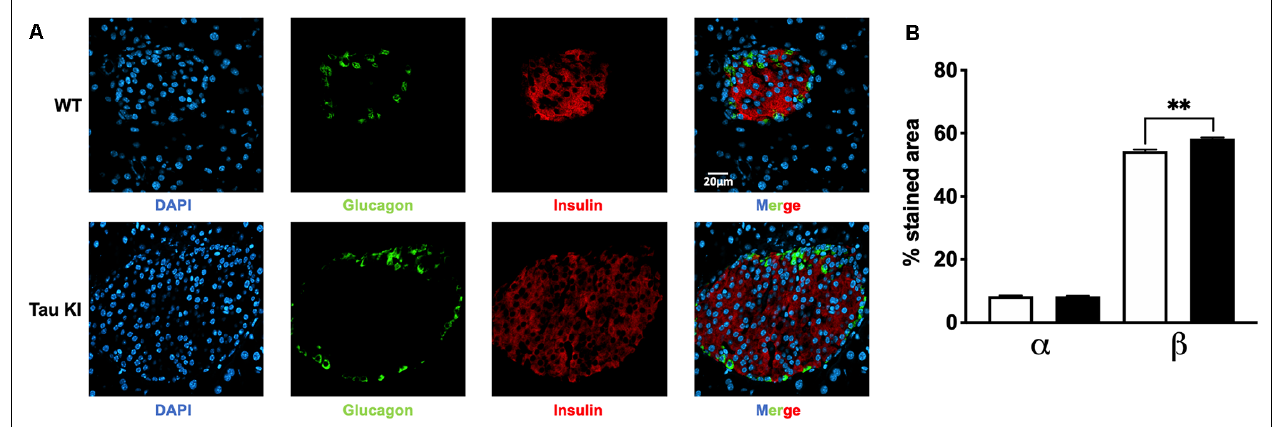
FIGURE 3 | Analysis for both α and β cell fraction. (A) Representative double immunofluorescence staining for insulin (red) and glucagon (green) in pancreas sections from adult WT and tau KI mice. DAPI nuclear counterstaining was used (blue). Magnification for pancreatic sections = x40, scale bars = 20 µ m. (B) Automated analysis of α and β cell fraction in pancreatic sections from tau KI and WT male mice under HFD ( N = 1,521–1,883 islets from three mice/group; Kruskal Wallis test, p < 0.001; ∗∗ p = 0.0096 using Dunn’s multiple comparisons test). Results are expressed as mean ± SEM. WT mice are indicated as white bars, tau KI mice as black